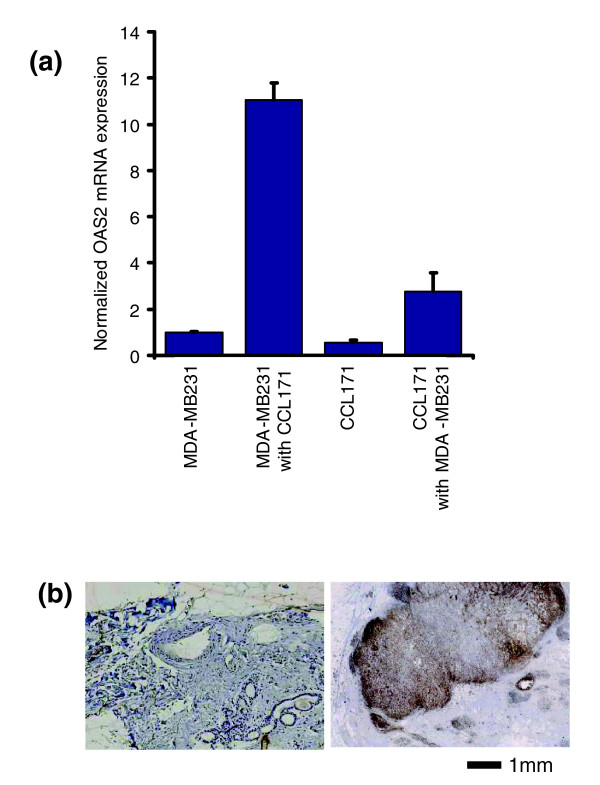
Interferon response gene induction in co-cultivated cells. (a) MDA-MB231 breast cancer cells and CCL-171 fibroblasts were labeled before co-culture with the fluorescent carbocyanine dye DiO and isolated after co-culture using FACS, which allowed a purification of 95%. Comparing gene expression patterns of the cells cultivated in monoculture to the same cell type after co-cultivation showed that the CCL-171 fibroblasts up-regulate the interferon response genes 2.8-fold on average, whereas the MDA-MB-231 breast cancer cell line up-regulates them about 11-fold. (b) Immunohistochemistry for STAT1. STAT1 expression in a normal breast (left panel) and in a breast cancer specimen (right panel). STAT1 is predominantly expressed in the malignant epithelial cells at the stromal interface in a centrifugal gradient.